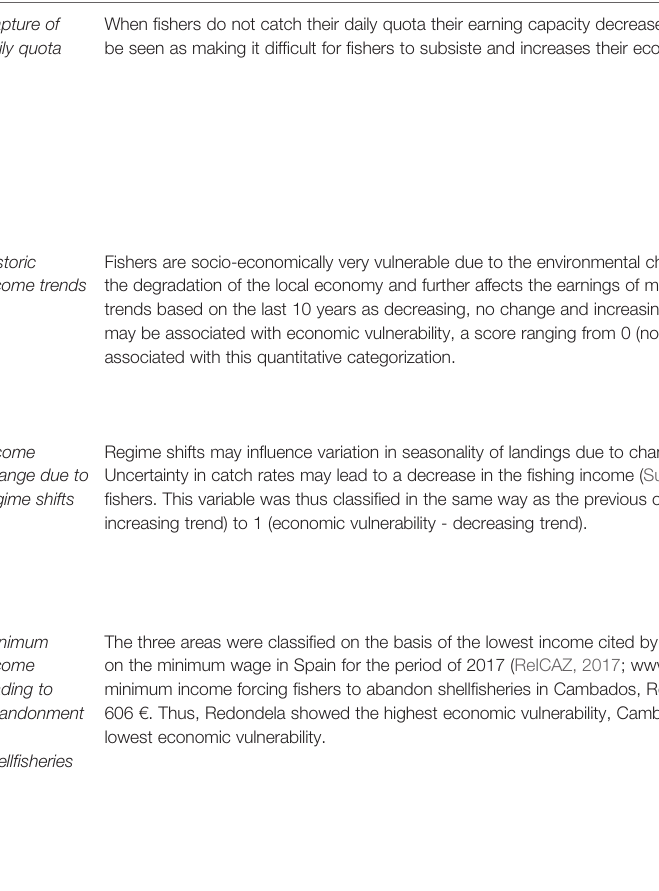
TABLE 1 | Description of the variables used to estimate fi shers ’ economic vulnerability.